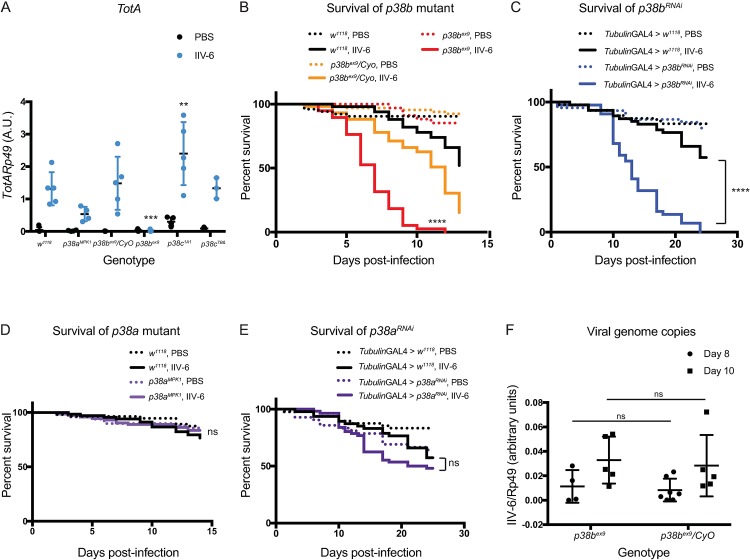
p38b is required for turandot induction and survival A) Mutant strains for the three p38 homologs, p38aMPK1, p38bex9, or p38c1A1, were infected with IIV-6 or injected with PBS, and TotA expression was measured by qRT-PCR 24 hours post-infection. Control genotypes included w1118 and p38bex9/CyO heterozygotes. The results of 3–5 biologically independent replicates are shown. Black bars indicate the mean and error bars represents standard deviation. Statistical analysis, comparing TotA levels in the virus infected control to mutant strains, was determined by two-way ANOVA with Sidak’s correction for multiple comparisons (***p = 0.0004, ** p = 0.0045) B) Kaplan-Meier curves showing survival of homozygous (p38bex9, red lines) or heterozygous (p38bex9/CyO, orange lines) p38b mutant flies following IIV-6 infection (solid lines) or PBS-injected controls (dotted lines) compared to control (w1118, black lines) flies. C) Kaplan-Meier curves showing survival of p38a mutant flies (red lines) following IIV-6 infection (solid lines) or PBS-injected controls (dotted lines) compared to control (w1118, black lines) flies. D) Kaplan-Meier curves showing survival of p38bRNAi expressing (blue lines) or E)
p38aRNAi expressing flies (purple lines) following IIV-6 infection (solid lines) or PBS-injected controls (dotted lines). UAS-p38aRNAi and UAS-p38bRNAi flies were crossed to tubulin-GAL4 for ubiquitous knock-down, while the control was generated by w1118 crossed to tubulin-GAL4 (black lines). Statistical significance was determined by Log-rank (Mantel-Cox) test (**** p <0.0001; ns, not significant). A.U., Arbitrary Units. F) Viral loads as determined by QPCR for p38bex9 and p38bex9/CyO heterozygous siblings. Each data point represents 5 flies. Error bars indicate standard error, and black lines indicate the mean. A.U., arbitrary units. Statistics were determined using two-way ANOVA. ns, not significant.